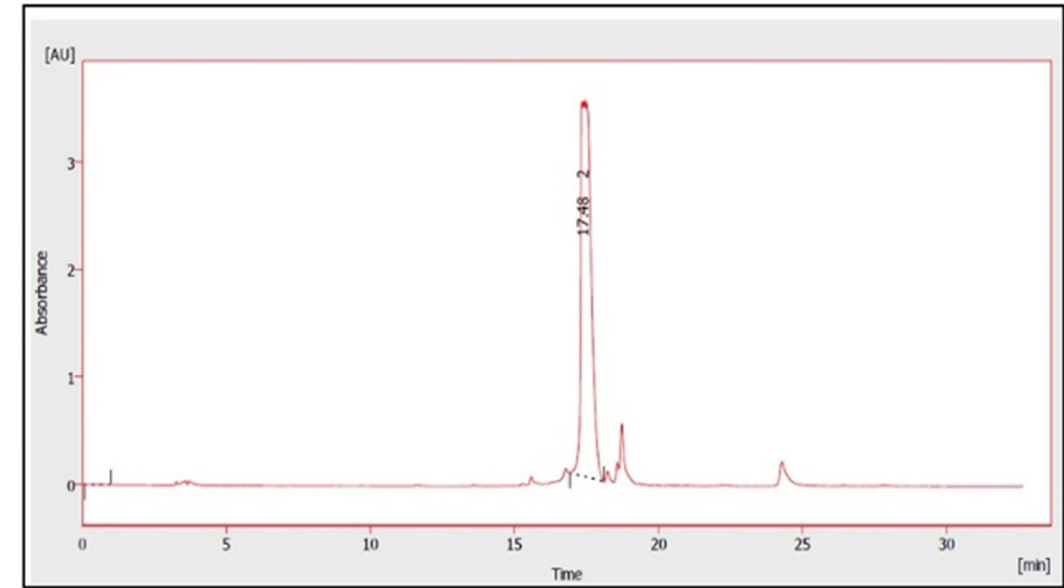
Figure A2: HPLC - PDA analysis of